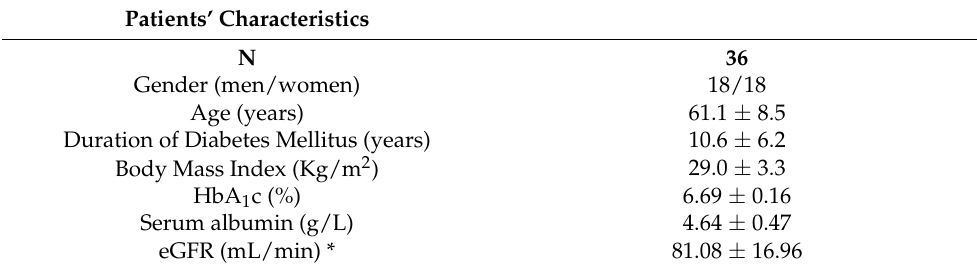
Table 1. Patients’ baseline